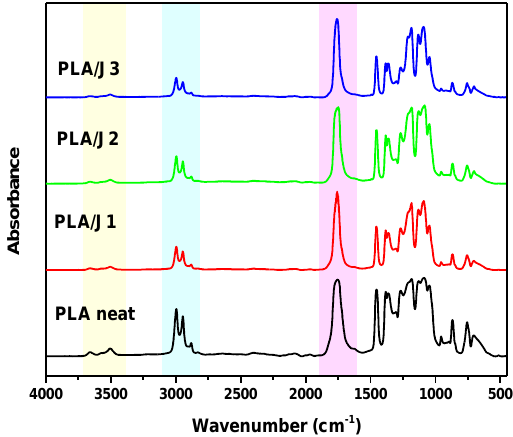
Figure 4. FTIR spectra of neat PLA and PLA/J.